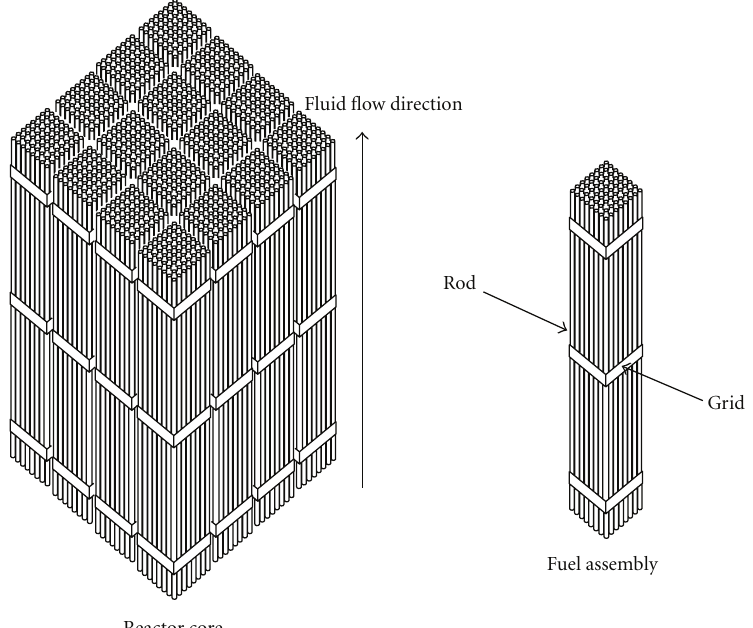
Figure 1: Part of a reactor core (left), part of a fuel assembly (right).